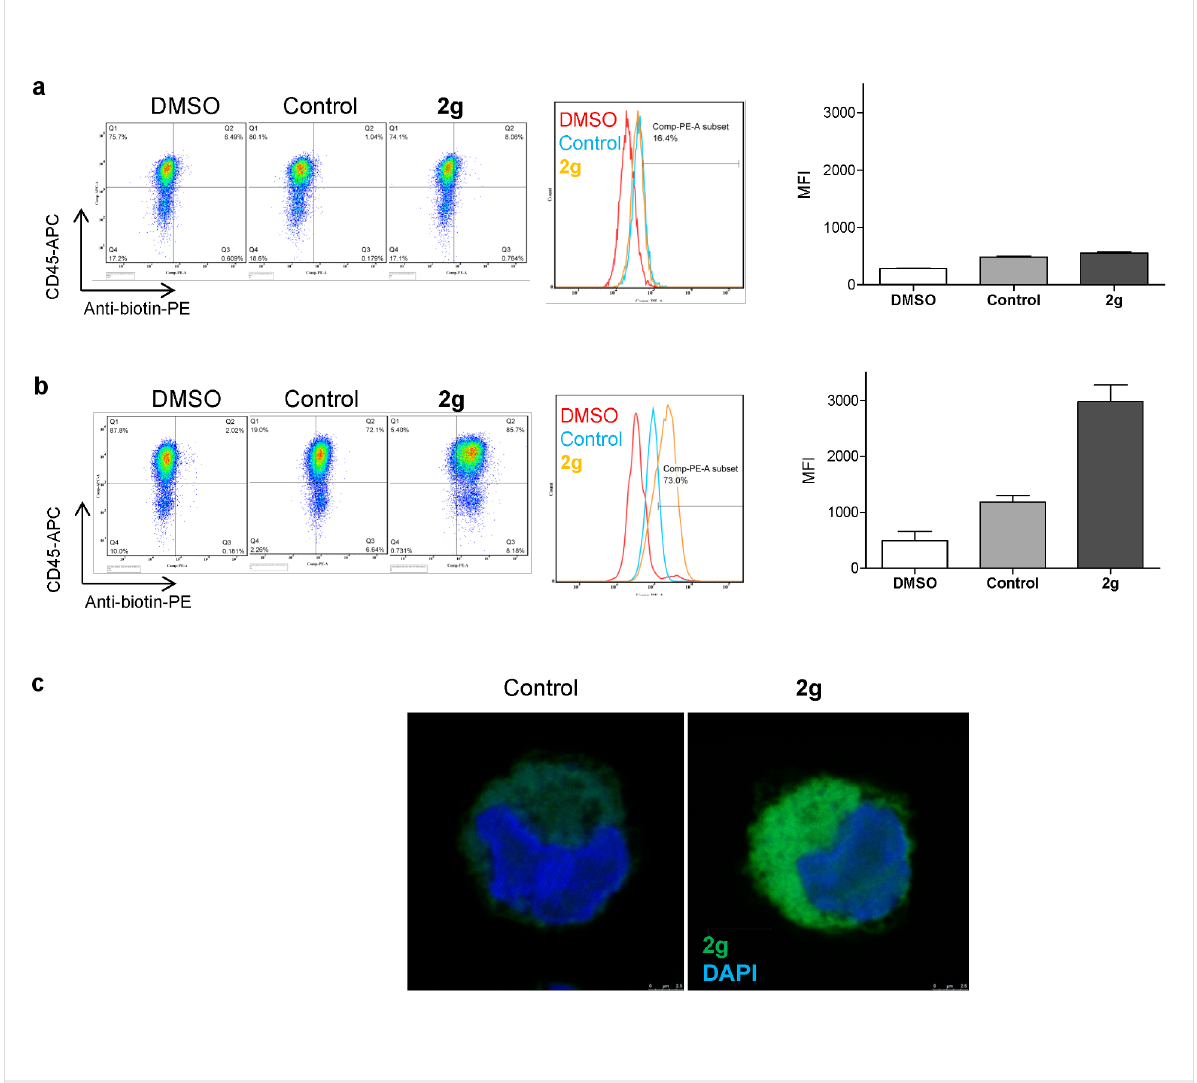
Figure 3: Use of probe 2g to detect oncogenic Hsp90 by flow cytometry (a) and (b) and by microscopy (c). For (b) and (c) cells were permeabilized with digitonin. DMSO, cells treated with vehicle only; control, cells treated with vehicle and stained with antibiotin-PE for flow cytometry and antibiotin- FITC for fluorescent microscopy; 2g , cells treated with probe 2g and stained with antibiotin-PE for flow cytometry and antibiotin-FITC for fluorescent microscopy. MFI, mean fluorescence intensity. CD45 is a plasma-membrane protein. For microscopy, nuclei were stained with DAPI. (a) and (b) right panels; quantification of repeat experiments ( n =